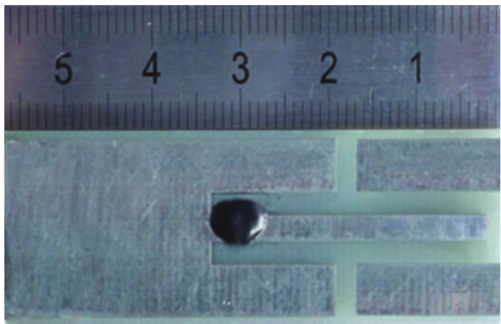
Figure 7: Photograph of the fabricated tag antenna.